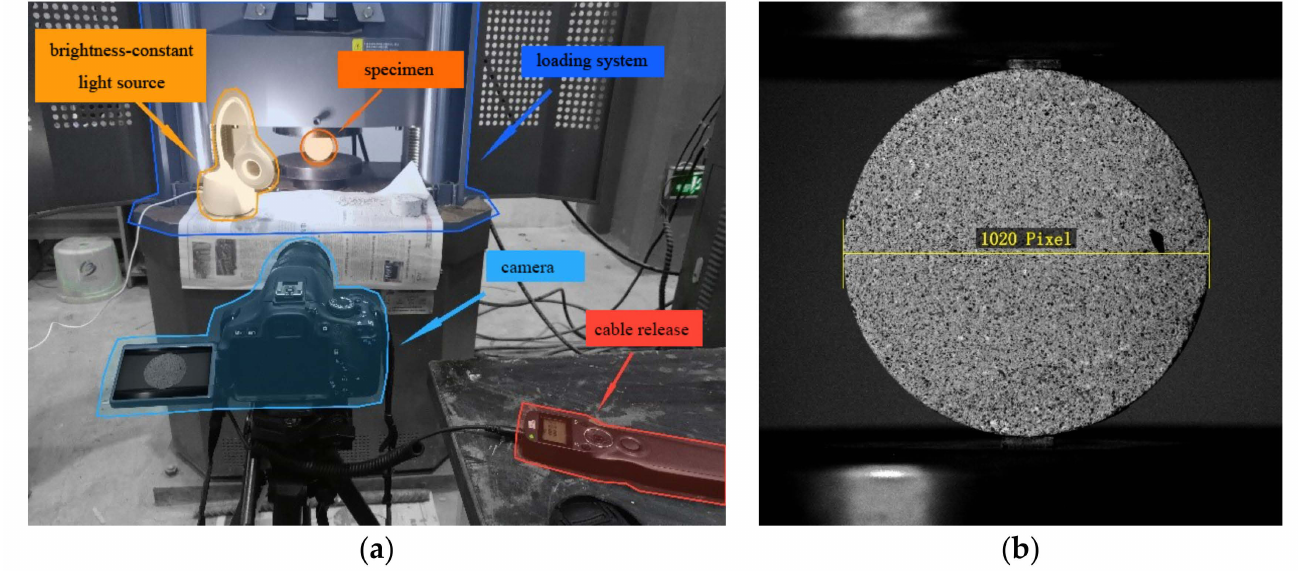
Figure 2. Digital image correlation (DIC) test system: ( a ) details of test setup, ( b ) images captured by